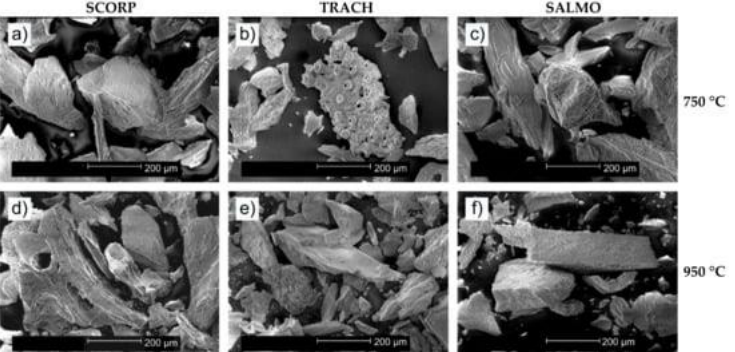
Figure 3. SEM images of porous and irregular structures in case of BCP powders derived from Red scorpionfish (SCORP) bones calcined at ( a ) 750 ◦ C and ( d ) 950 ◦ C, Atlantic horse mackerel (TRACH) bones calcined at ( b ) 750 ◦ C and ( e ) 950 ◦ C, and salmon (SALMO) bones calcined at ( c ) 750 ◦ C and ( f ) 950 ◦ C. (Magnification bar: 200 µ m). Reproduced with permission from [109]. Copyright 2021. MDPI,